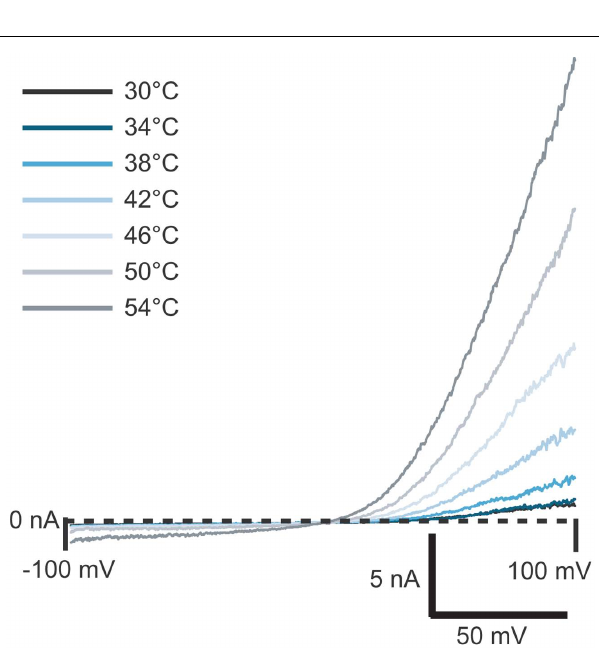
FIGURE 4 | Current traces ofTRPV3 activated by heated solution. External solution was heated to the temperature shown and applied to the cell. Currents started to activate at ≥